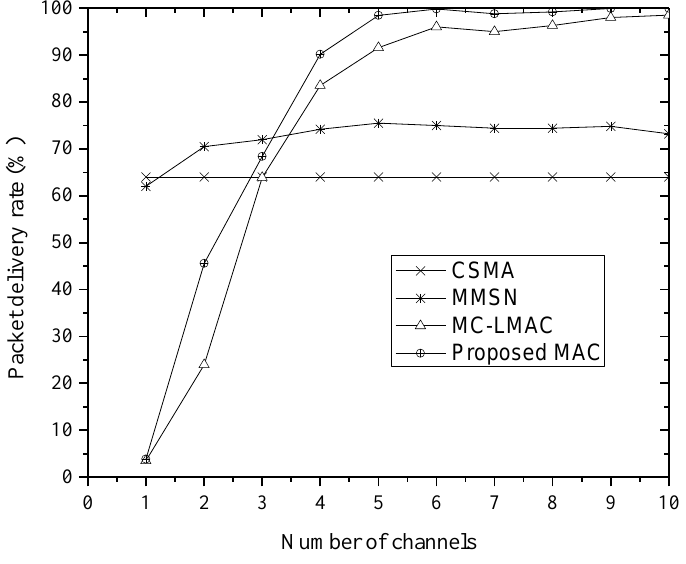
Figure 4. Packet delivery rate with different number of